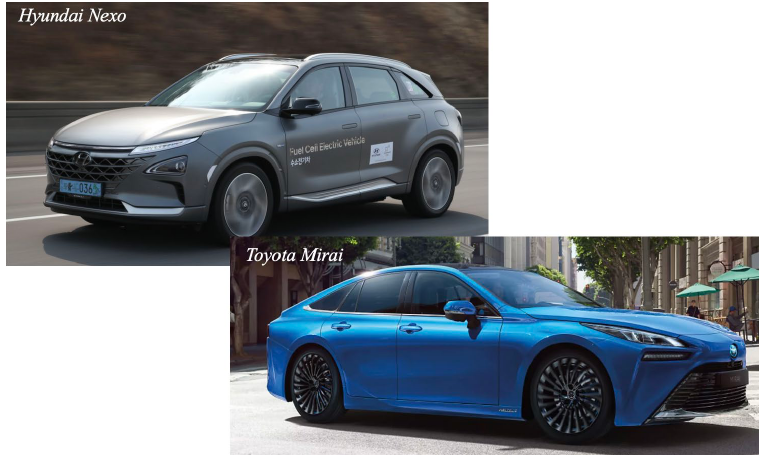
Figure 2. Photos of the Hyndai Nexo and the Toyota Mirai (available online).